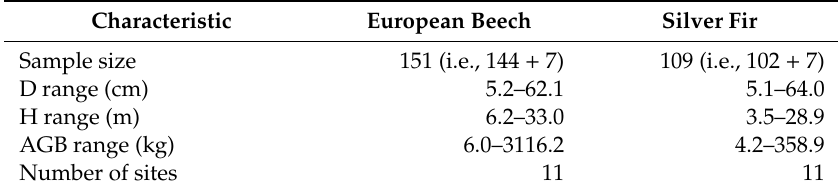
Table 4. The characteristics of Dataset